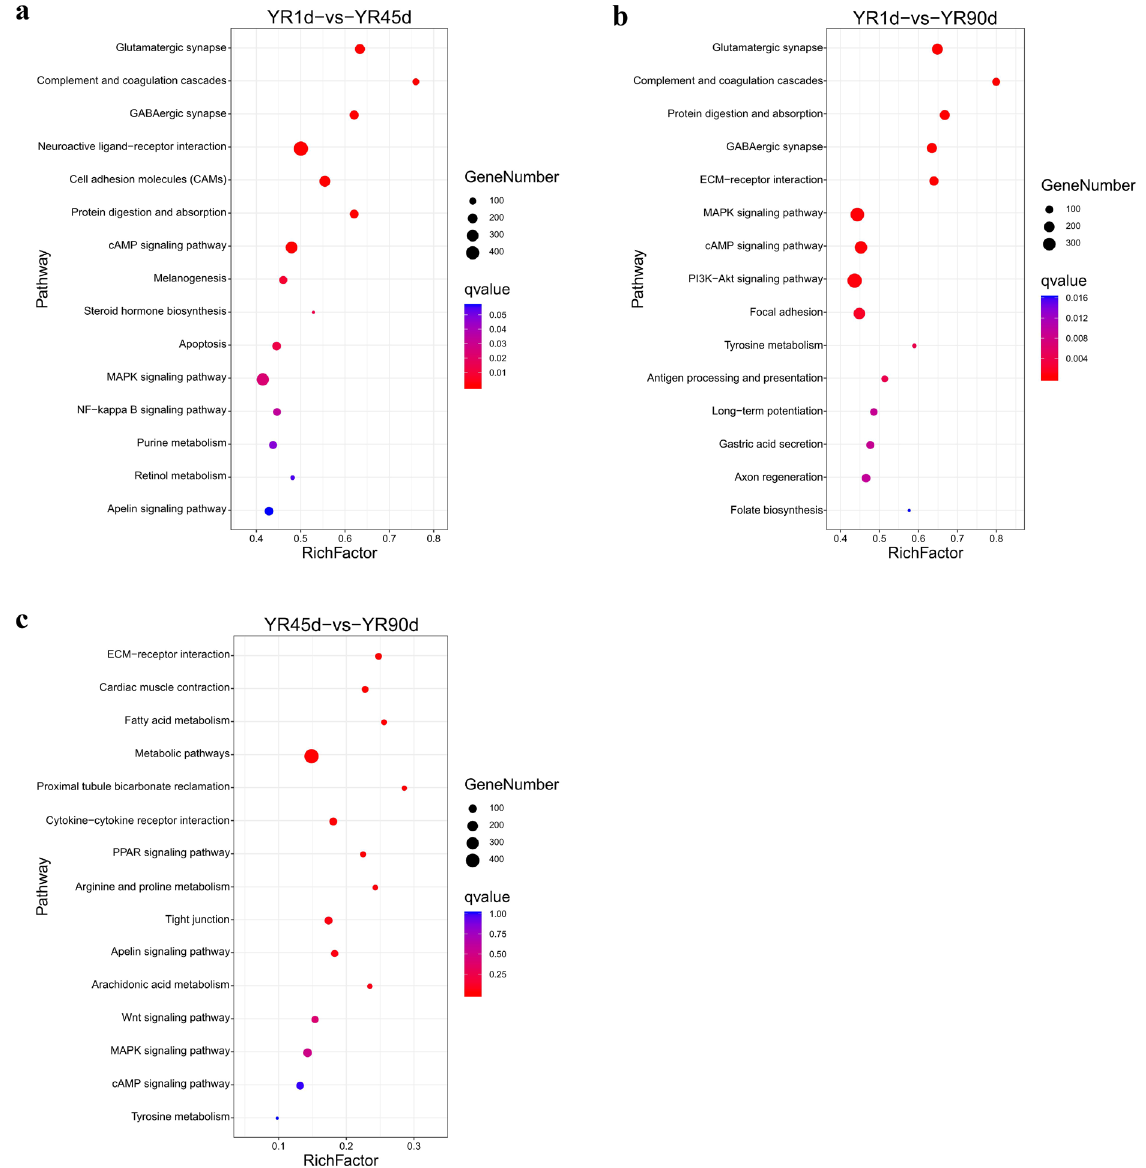
Figure 7. Scatterplot of enriched KEGG pathways (www. kegg. jp/ kegg/ kegg1. html) for DEGs among the three compared groups. ( a ) YR1d vs. YR45d. ( b ) YR1d vs. YR90d. ( c ) YR45d vs. YR90d. Rich factor is the ratio of the DEG number to the total gene number in a given